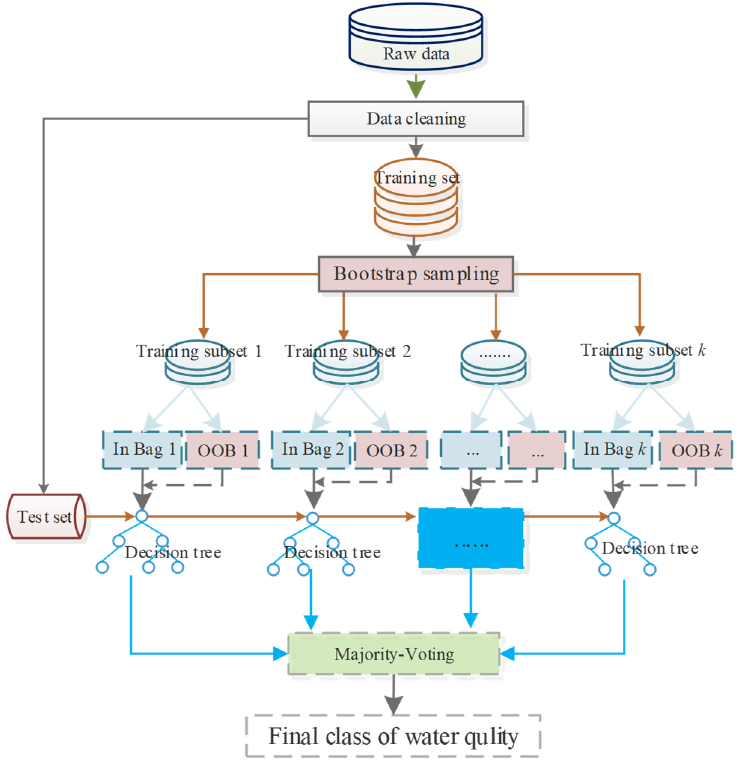
Figure 8. Flowchart of the water quality analysis algorithm. k , the number of trees; OOB, out-of-bag.